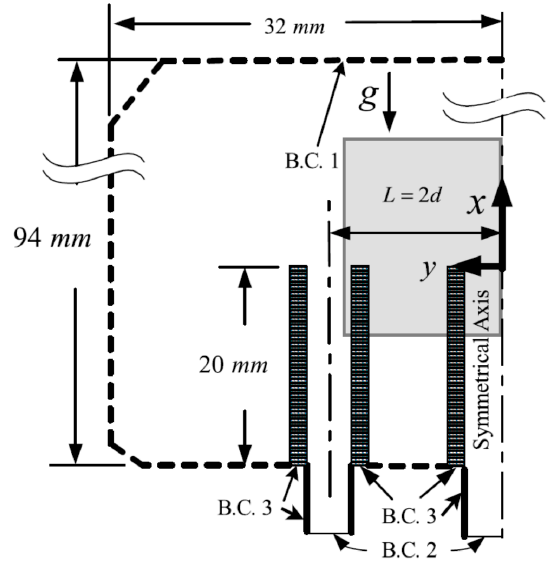
Figure 2. The computational domain and inlet and boundary conditions. The gray block near the x - and y -axes is the area shown in Figures 5–11. Boundary condition (B.C.) 1: fixed pressure (gauge p = 0)